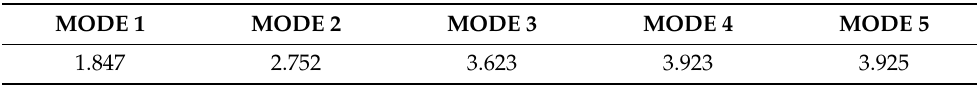
Table 8. Case 2: Natural frequencies tank water filled.